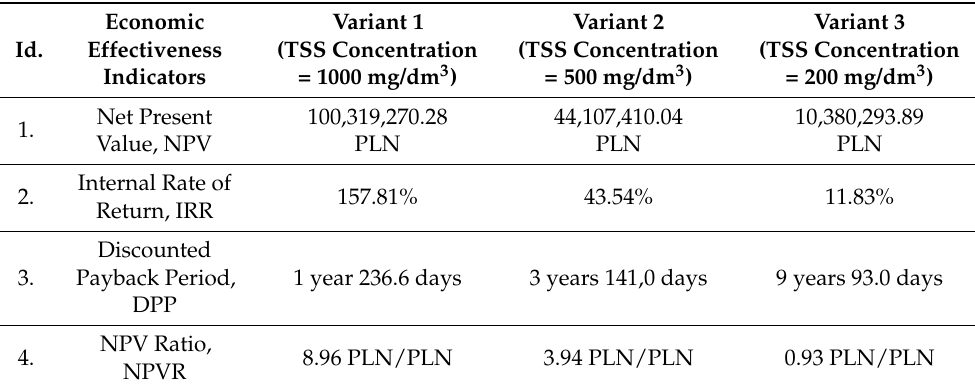
Table 5. The values of economic effectiveness indicators in the analyzed variants.